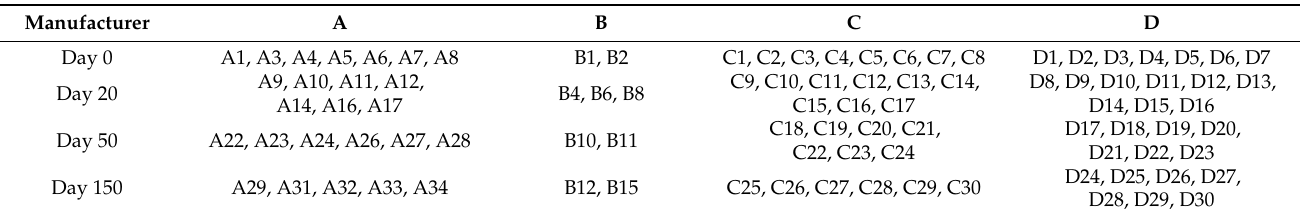
Table 1. CNS isolates from manufacturers A, B, C and D with time of isolation.